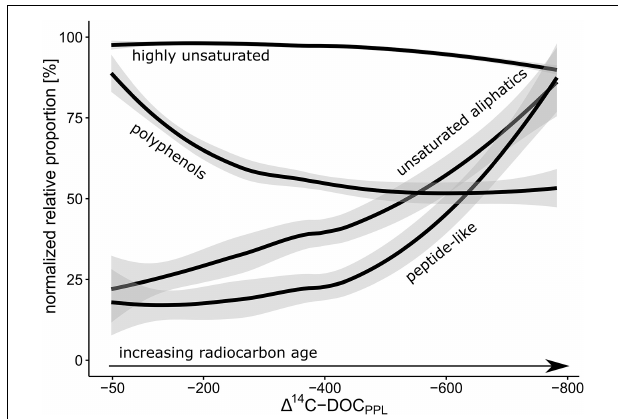
FIGURE 4 | Relative proportions of major molecular subgroups in DOM with respect to 14 C depletion, normalized to the respective within-group maxima. Lines result of a locally estimated scatterplot smoothing (LOESS), gray areas indicate 95% confidence